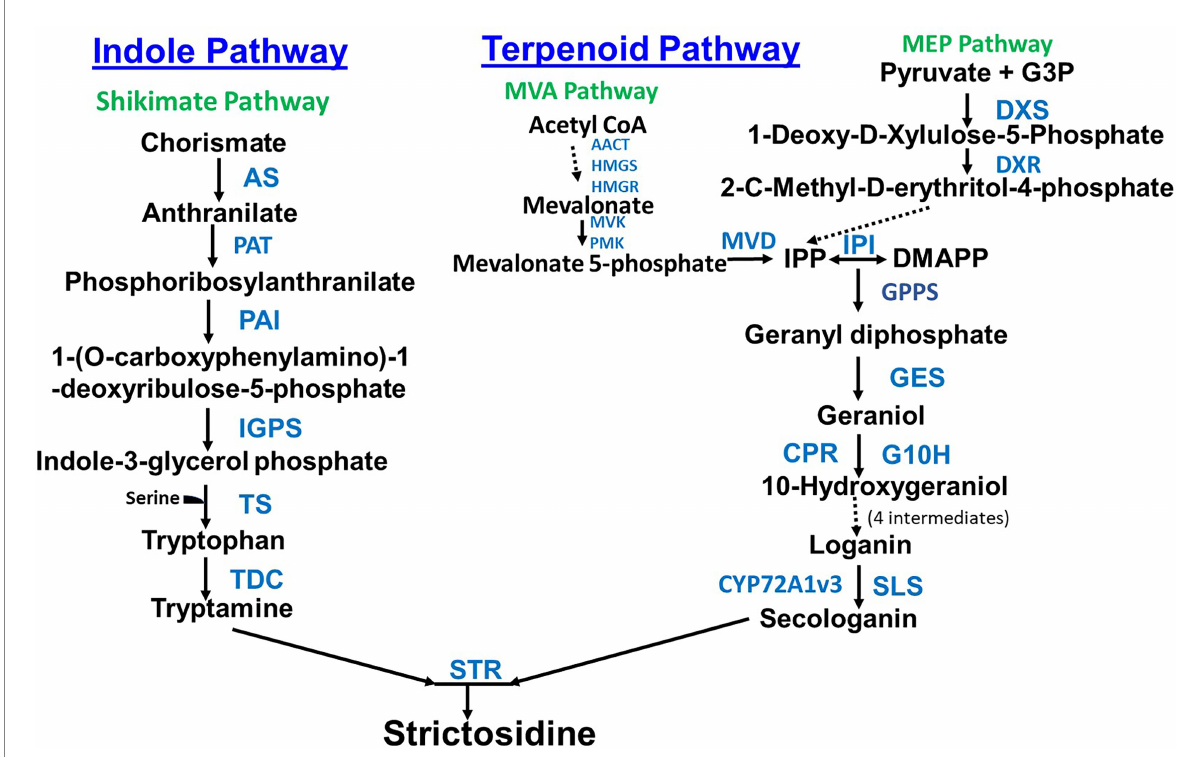
FIGURE 2 Biosynthesis of terpenoid indole alkaloids starting from strictosidine. Enzyme abbreviations are as follows: 16OMT (16-hydroxytabersonine 16-O-methyltransferase), ASO (O-acetylstemmadenine oxidase), AVLBS (anhydrovinblastine synthase), CS (catharanthine synthase), D4R (desacetoxyvindoline 4-reductase), DAT (deacetylvindoline 4-Oacetyltransferase), DPAS (dihydroprecondylocarpine synthase), GO (geissoschizine oxidase), GS (geissoschizine synthase), HL1 ( α / β hydrolase 1), HL2 ( α / β hydrolase 2), HYS (heteroyohimbine synthase), NMT (N-methyltransferase), PAS (precondylocarpine acetate synthase), SAT (stemmadenine-O-acetyltransferase), SGD (strictosidine β -D-glucosidase), SS (serpentine synthase), T16H (tabersonine 16-hydroxylase), T19H (tabersonine 19-hydroxylase), T3O (tabersonine 3-oxidase), TEX1/2 (tabersonine 6,7-epoxidase), TR3 (tabersonine 3-reductase), and TS (tabersonine